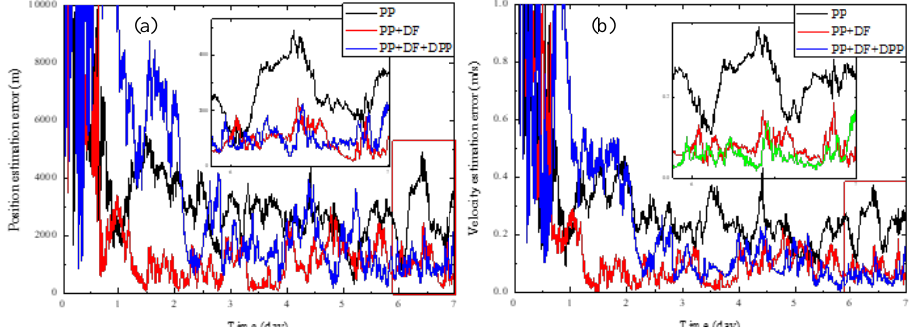
Figure 3. Performance comparison of different navigation measurements without systematic biases. ( a ) Position estimation error; ( b ) Velocity estimation error.